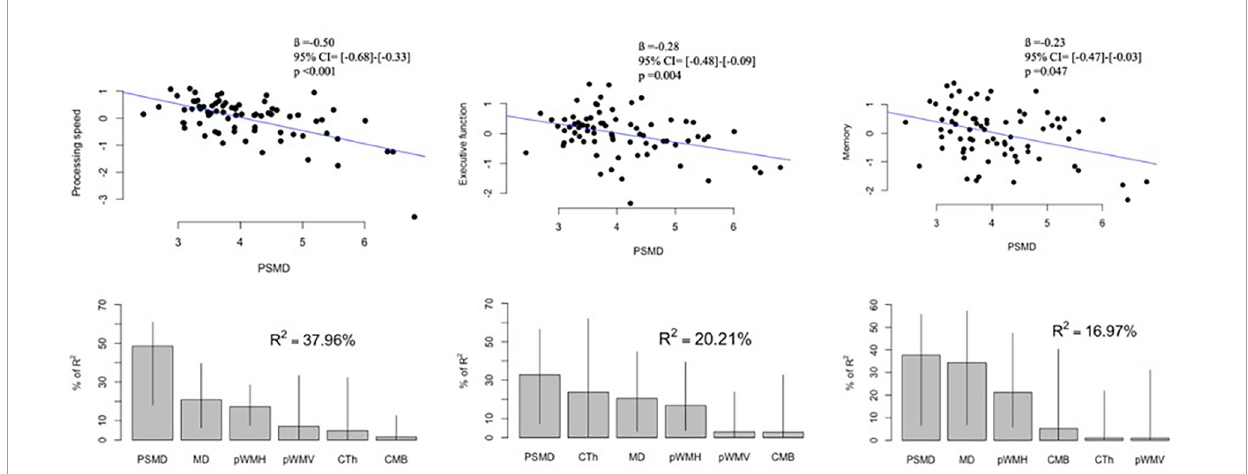
FIGURE4 Associations between PSMD and cognitive scores in patients with cerebral amyloid angiopathy: Upper panel shows correlation plots between PSMD ( × 10 - 4 mm 2 /s) and z scores of processing speed, executive function, and memory. The values of ß, 95% CI and p were adjusted for age, sex, and years of education. Lower panel demonstrates the contribution of each MRI marker to the multiple regression models. Lines represent 95% confidence intervals after bootstrapping. PSMD, peak skeletonized mean diffusivity; MD, mean diffusivity; pWMH, percent of white matter hyperintensity to estimated intracranial volume; pWMV, percent of white matter volume to estimated intracranial volume; CTh, cortical thickness; CMB, cerebral microbleed